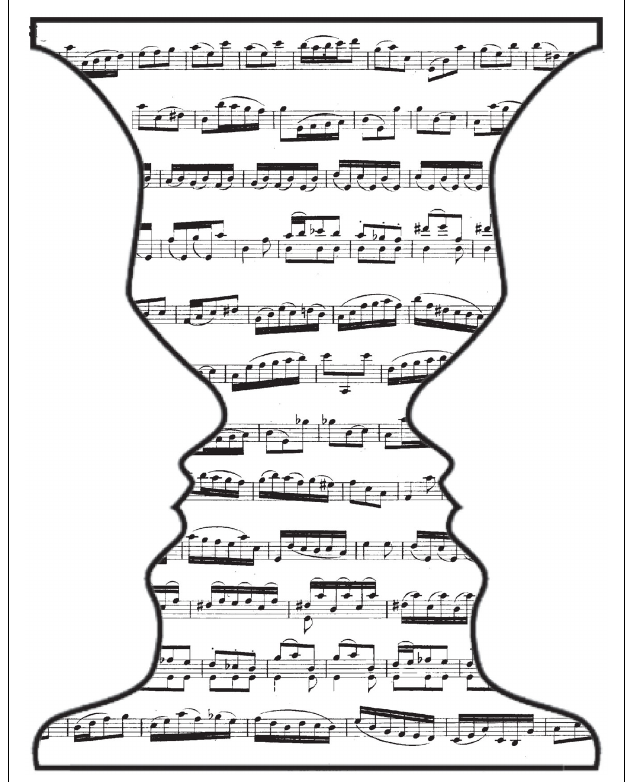
FIGURE 4 | Illustration of visual bistability. This ambiguous picture may be seen as either two faces looking at each other, or as a single vase ( original illustration: J. M. Hupé ).When looking at the picture for a prolonged period of time, the two interpretations may alternate in the mind of the observer. Another example of such bistable alternations can be obtained with ambiguous motion stimuli. For a demonstration, see for instance: